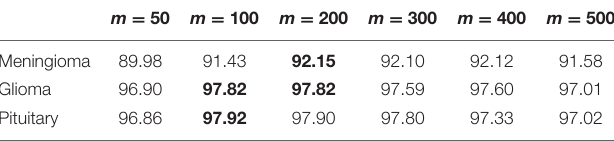
The bold values represent the best results in comparison